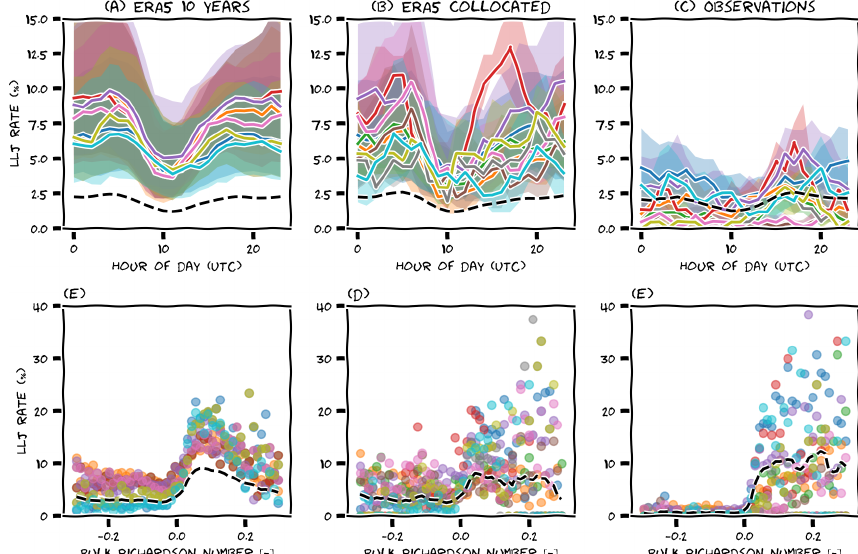
Figure 8. Average low-level jet rate for each hour of the day (a–c) and as function of the bulk Richardson number (d–f) , for the full (10 years) of ERA5 data up to 500m (a, d) , a subset of this data collocated with the observations (b, e) , and the observed data (c, f) . Like in Fig. 6, the black dashed lines represented a scaled and smoothed aggregated signal based on all